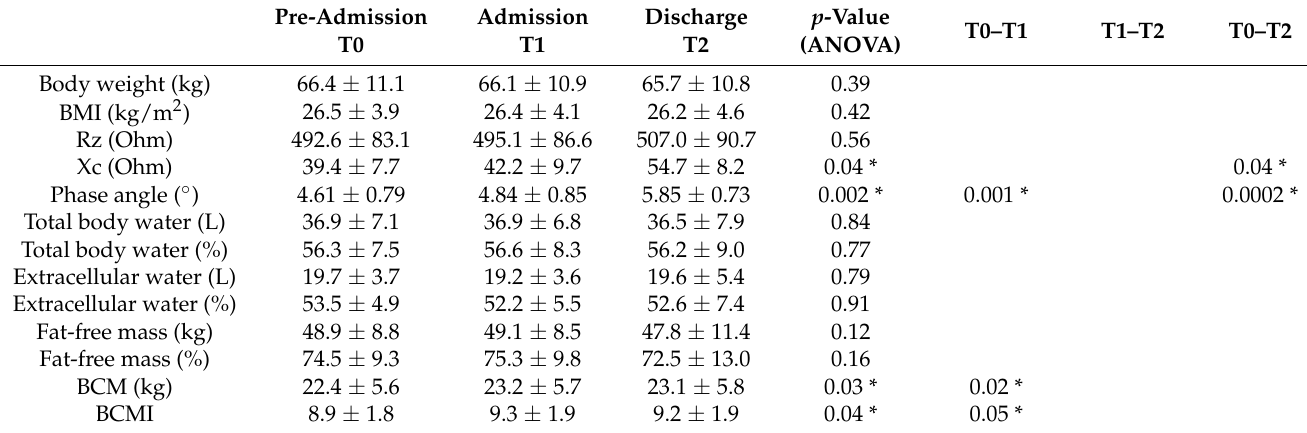
Table 3. Body Composition changes between Pre-Admission and Admission in Patients following NutriCatt protocol ( n =